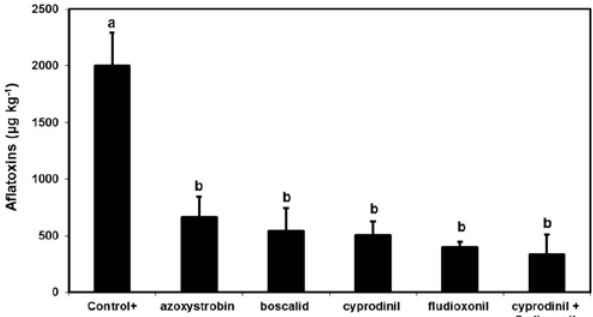
Figure 5. Mean aflatoxins contents (μg kg -1 ) in maize ker - nels from field grown plants that were artificially inocu - lated with Aspergillus flavus strain A6.10 and treated with different fungicides. Columns accompanied by different letters are significantly different ( P ≤0.05) according to Tuk - ey’s HSD test. Vertical bars indicate standard errors of the